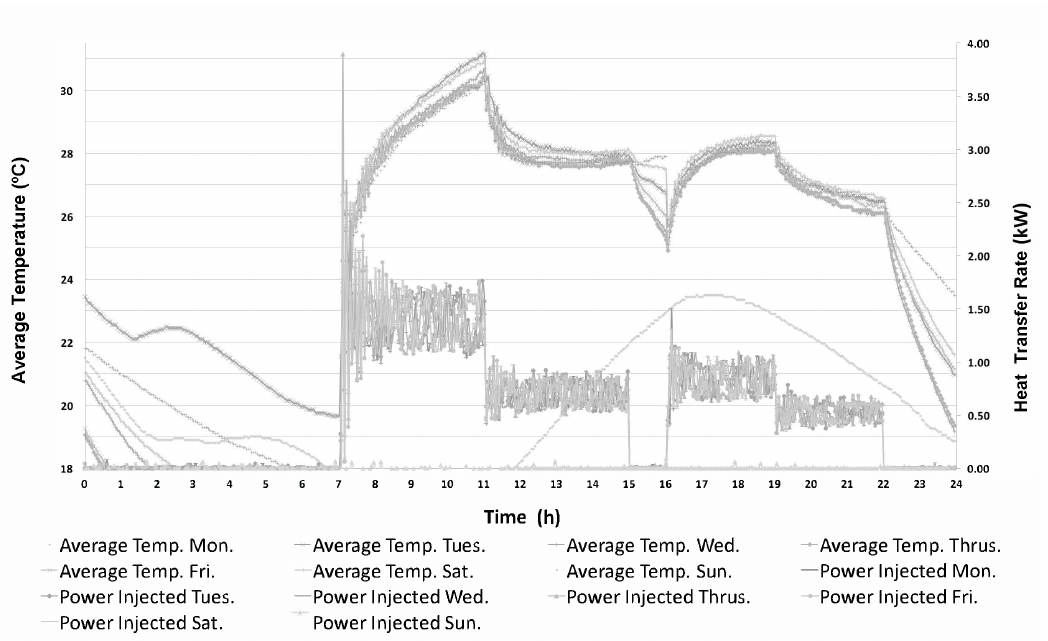
Figure 11. Superposition of daily cycles during the second week of the